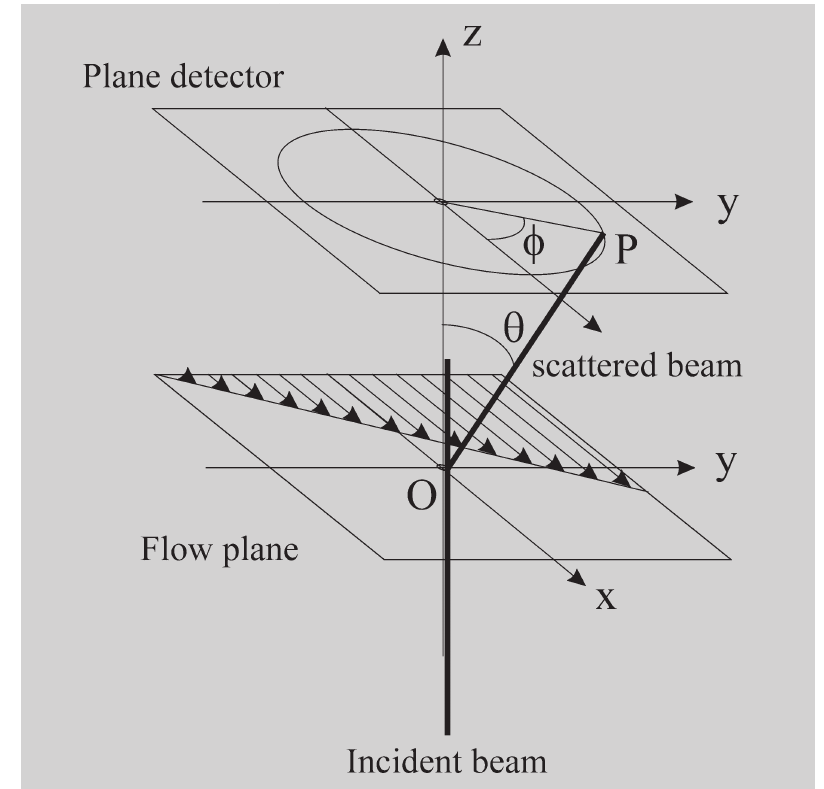
Figure 1: Schematic view of the shear experiment geom- etry